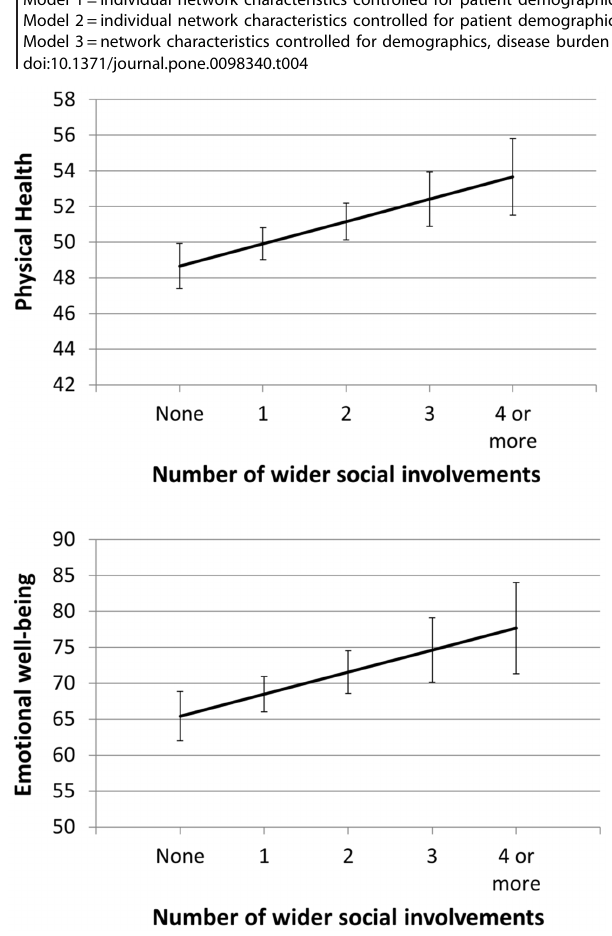
Figure 1. Modelled relationships (mean score and 95% confidence interval) between physical health and number of social involvements, and emotional well-being and number of social involvements, controlled for patient sociodemo- graphics, disease burden and other significant social network characteristics (Model